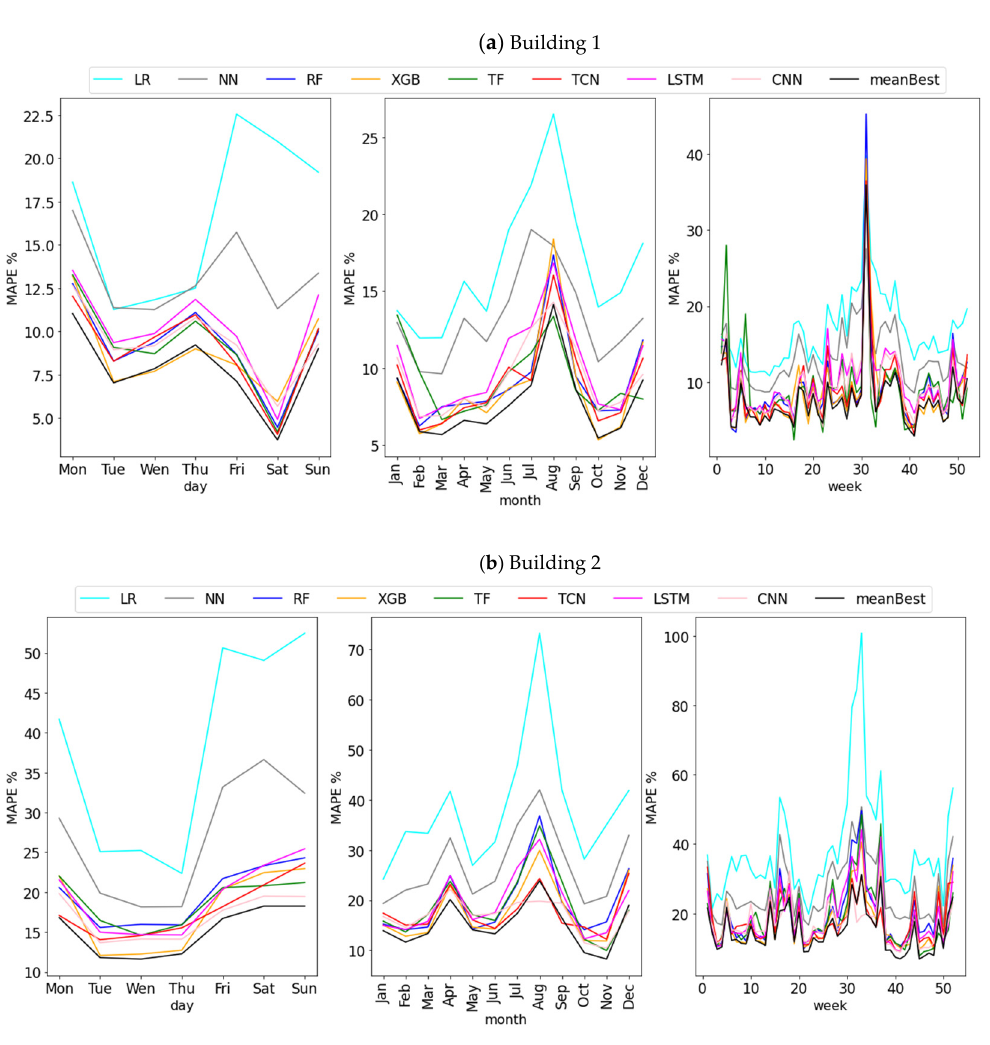
Figure 6. ( a ) Performance of forecasting models by day, month, and week in building 1; ( b ) performance of forecasting models by day, month, and week in building 2.